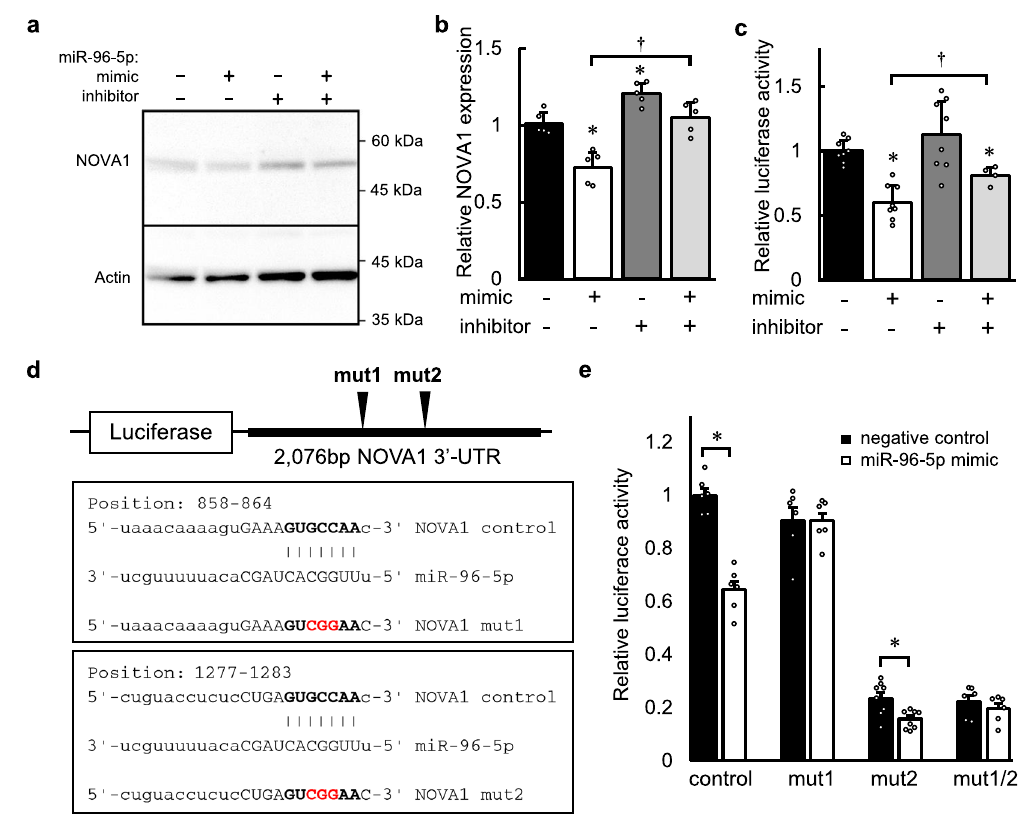
Fig. 3 The effect of miR-96-5p on the expression of an RNA-binding protein, NOVA1. a The endogenous expressions of NOVA1 and β -actin in Neuro2a cells with transfection of the miR-96-5p mimic and/or inhibitor are shown. Molecular weight markers are depicted at right. The full blots are presented in Supplementary Fig. 14. b Densitometric quanti fi cation of the data in panel a is shown. Data represent mean values ± SD obtained from fi ve independent experiments and individual data points are plotted. Data were analyzed by one-way ANOVA( F (3,16) = 23.84, p = 0.0000038) and Tukey ’ s HSD test. * p < 0.05 relative to the negative control. † p < 0.05 versus the effect of the miR-96-5p inhibitor. c Relative luciferase activity in SH-SY5Y cells transfected with the luciferase plasmid of NOVA1 3 ′ -UTR with the miR-96-5p mimic and/or inhibitor are shown. Data represent mean values ± SD obtained from independent samples ( n = 8 for negative control, miR-96-5p mimic or miR-96-5p inhibitor, n = 4 for miR-96-5p mimic plus inhibitor) and individual data points are plotted. Data were analyzed by one-way ANOVA( F (3,24) = 13.24, p = 0.000027) and Tukey ’ s HSD test. * p < 0.05 relative to the negative control. † p < 0.05 versus the effect of the miR-96-5p inhibitor. d A schematic plot of the luciferase constructs of NOVA1 3 ′ -UTR is shown. The sequences for the predicted miR-96-5p target sites are shown in the box. Mutation was added in a core sequence (red font) of the miR-96-5p target (bold font). e Relative luciferase activities in SH-SY5Y cells transfected with the luciferase plasmids in d with the miR-96-5p mimic are shown. Data represent mean values ± SD obtained from independent samples ( n = 6 for control, mut1 or mut1/2, n = 8 for mut2) and individual data points are plotted. Data were analyzed by Student ’ s t -test, two-sided. * p < 0.05 relative to the negative control in each